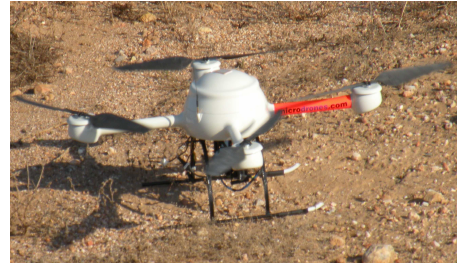
Figure 1. The vertical take off and landing UAV used for the flight mission